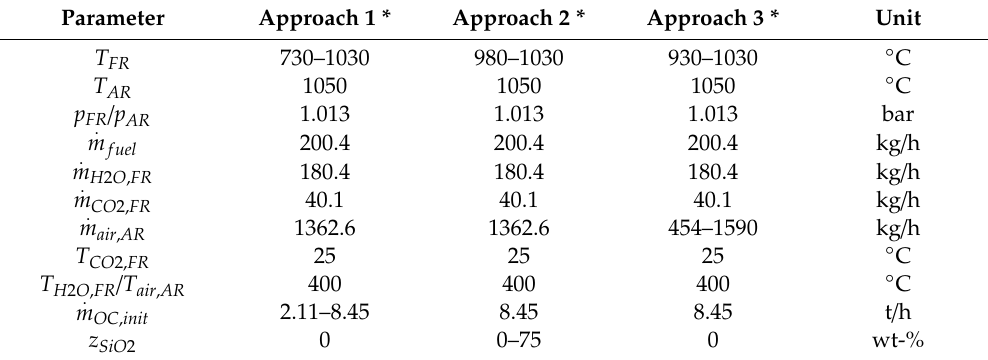
Table A1. Boundary conditions for 1 MW th CLC / CLG process model for di ff erent CLG approaches.